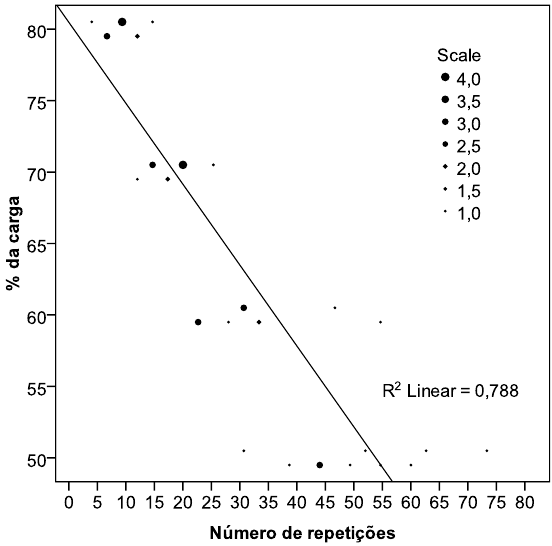
Figura 5. Dispersão dos valores no rosca scott nos diferentes percentuais de 1RM avaliados